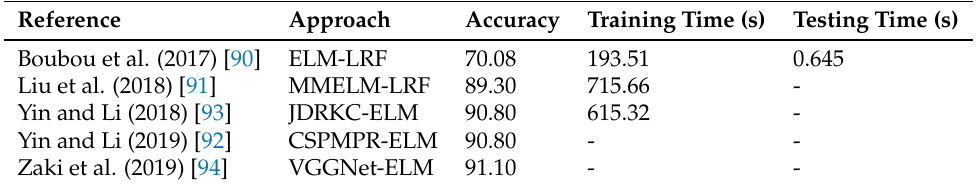
Table 17. The results obtained by CELM architectures for RGB-D classification in Washington RGB-D Object